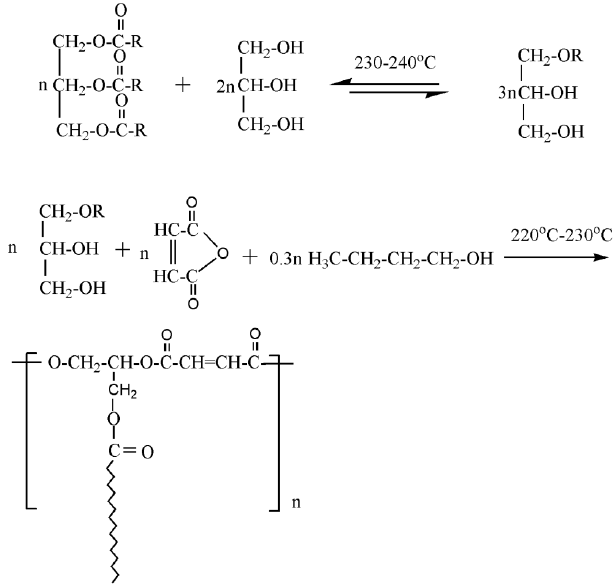
Figure 10. Synthesis bio-based polyester plasticizer from palm oil.